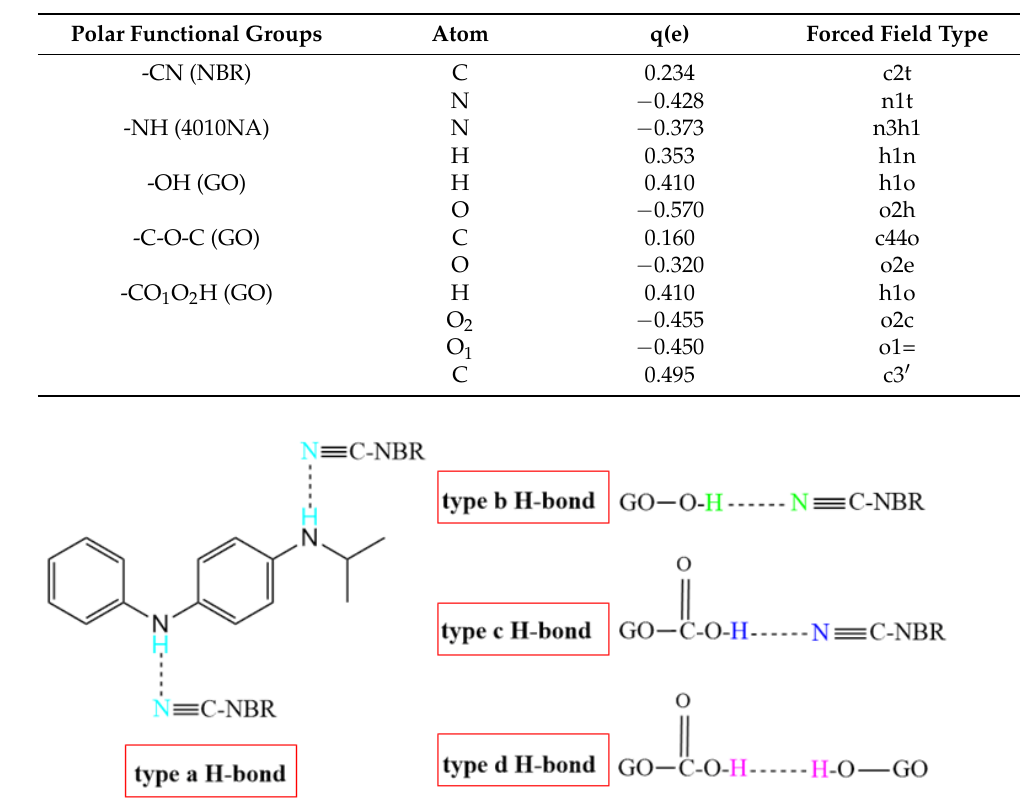
Table 4. Charges and forced field type of the atoms.